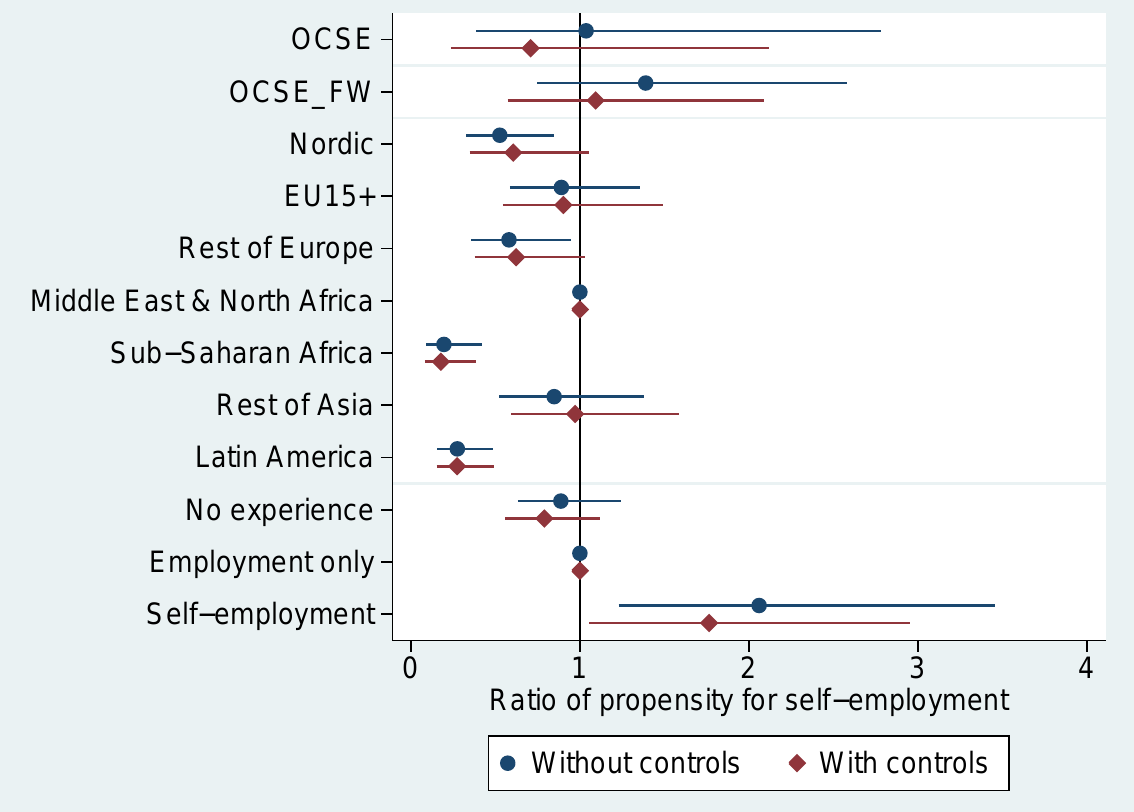
Figure 3: Propensity for self-employment using Cox regression. Regression results with 95 percent confidence intervals (from robust standard errors) for Cox regression, with time to entry into first self-employment as the dependent variable, are shown. See Table S3 in the online supplement for full